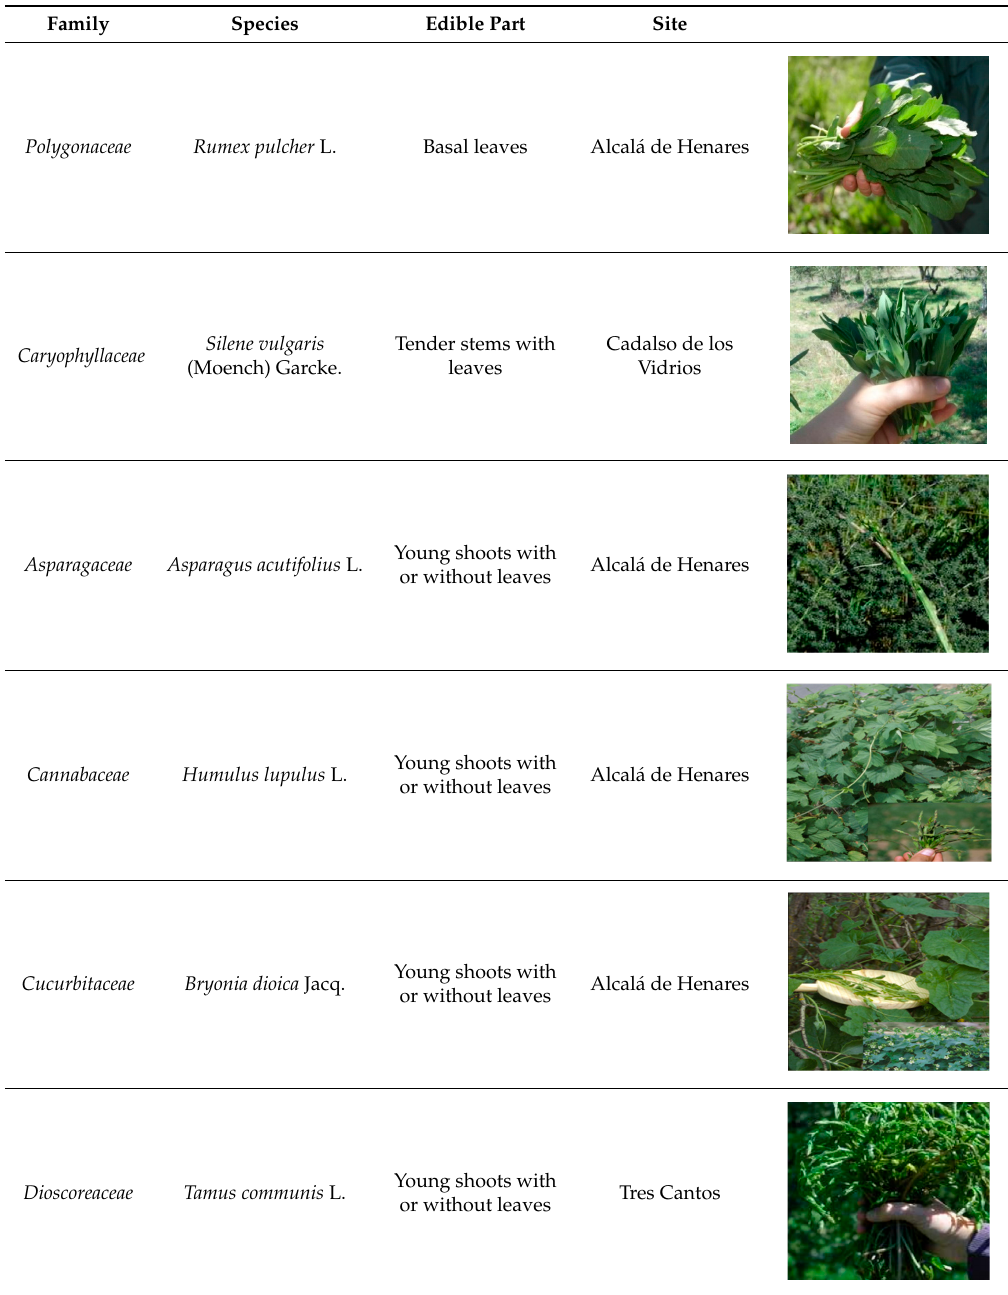
Table 1. Description and location of the sampled wild vegetable species.